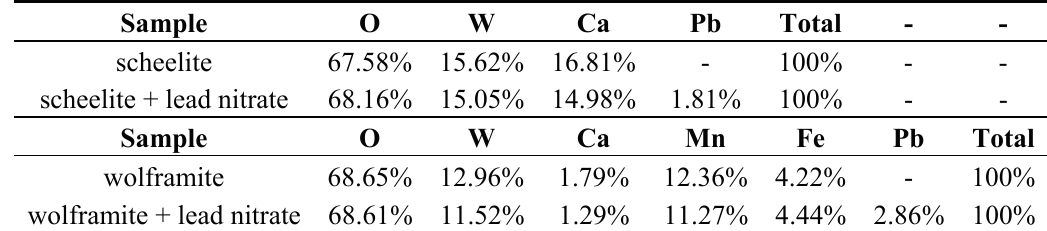
Table1. Atom percentages for various samples as determined by X-ray photoelectron spectroscopy (XPS).